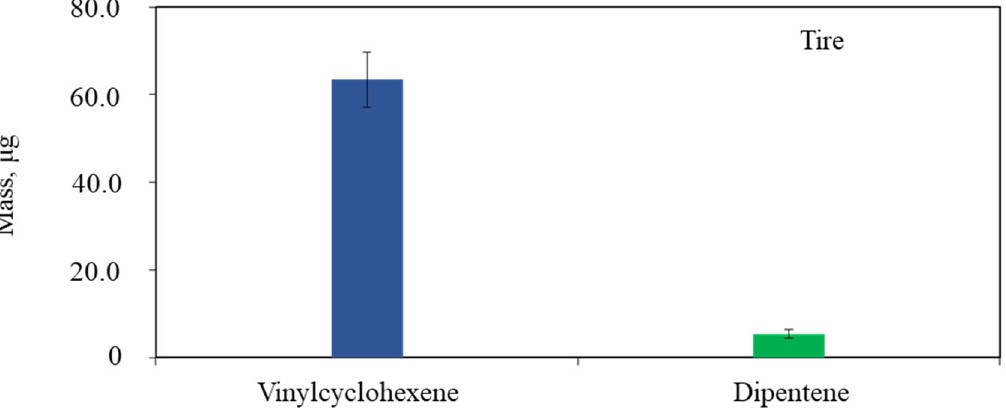
Figure 4. The average mass of vinylcyclohexene and dipentene of the tire samples with 95% confi- dence intervals of the error bars.